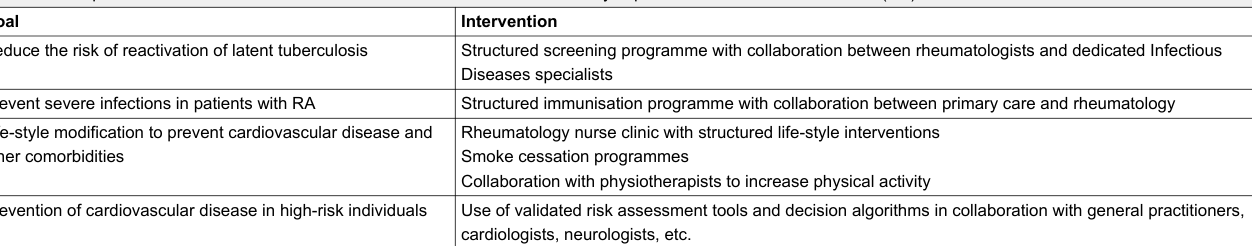
Table 1: Examples of collaborative interventions to reduce the burden of comorbidity in patients with rheumatoid arthritis (RA). Goal Intervention Reduce the risk of reactivation of latent